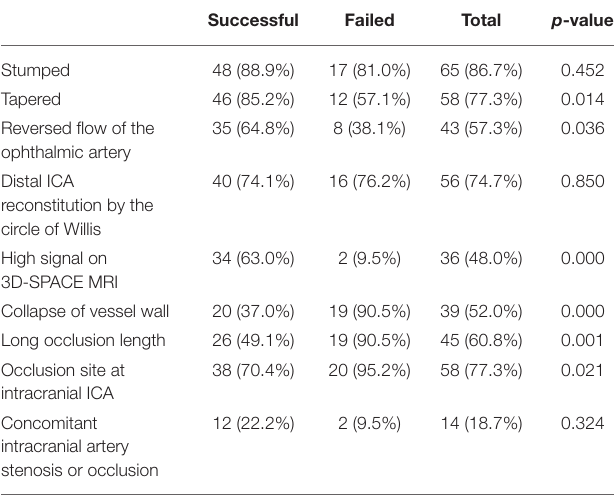
TABLE 2 | Radiologic characteristics of the patients.